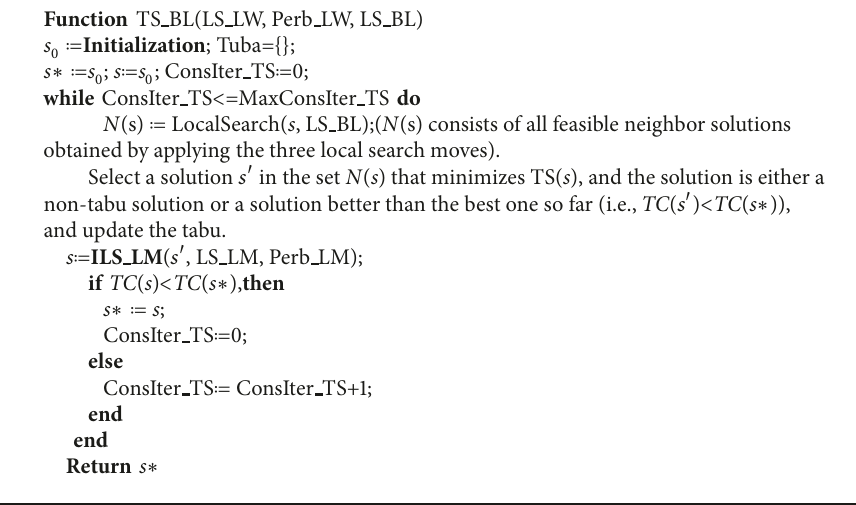
Algorithm 4: TS for bi-level